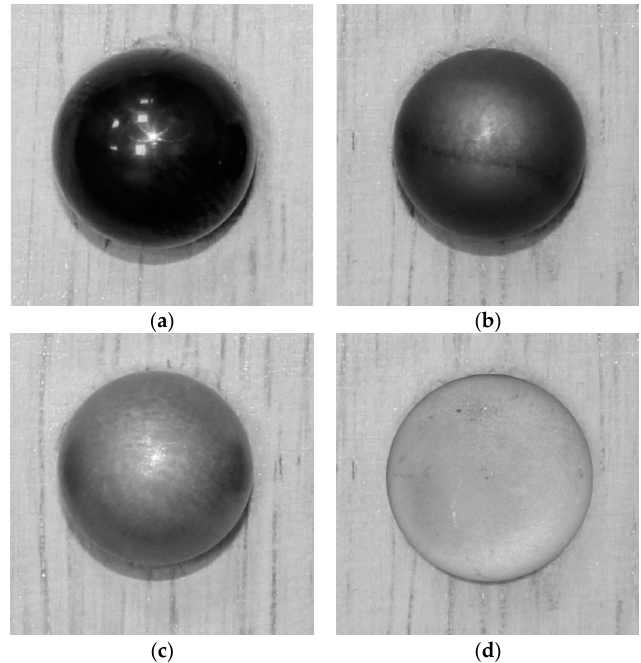
Figure 7. Specimen view: ( a ) Initial CPC; ( b ) CPC No. 1 after electrolysis (NaCl–KCl–NaF (10 wt %)– K 2 NbF 7 (8 wt %), i = 5 × 10 − 3 A·cm − 2 , τ = 8 h, t = 750 ° С ); ( c ) CPC No. 2 after electrolysis (the same melt,